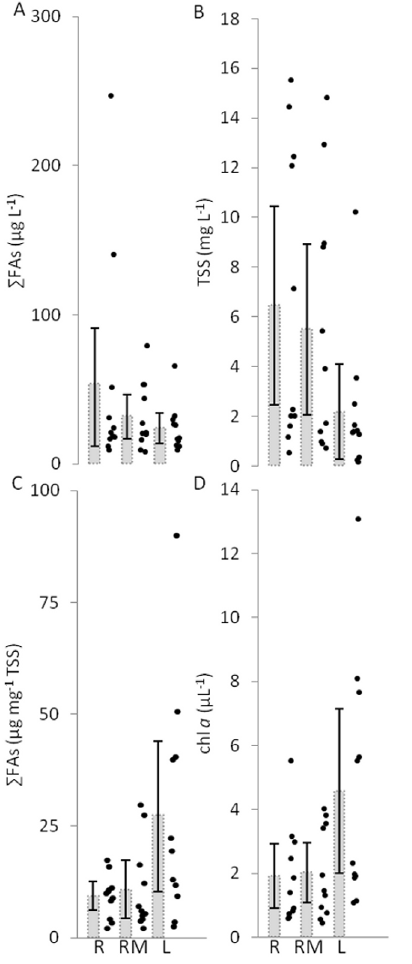
Figure 3. Total fatty acid ( g FA) quantity and as a proportion of the total seston, total suspended solids (TSS) and chlorophyll a (chl a ) in rivers (R), rivermouths (RM) and the nearshore of Lake Michigan (L). Raw data (points) and averages (with 95% credible intervals) are shown here. Although not presented, the trends in g FA in seston largely mirror trends in other seston FAs measured here (see Table S3 and Appendix S2). Statistical significance is inferred by the lack of overlap between credible intervals (no statistically significant differences occur here).